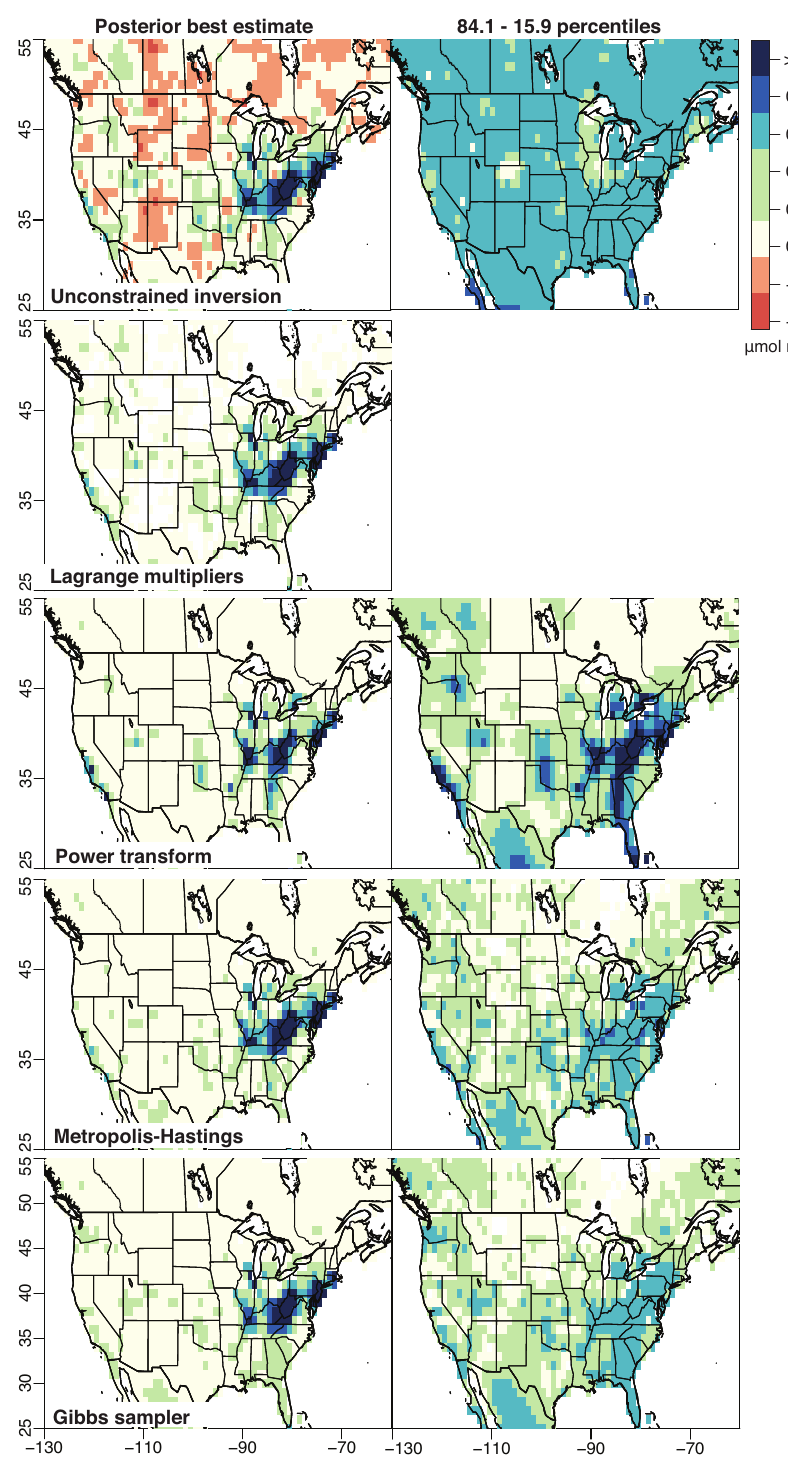
Fig. 2. The posterior best estimate of the emissions and uncertainties associated with each methodological approach. The method of Lagrange multipliers does not support a direct means of estimating uncertainties.